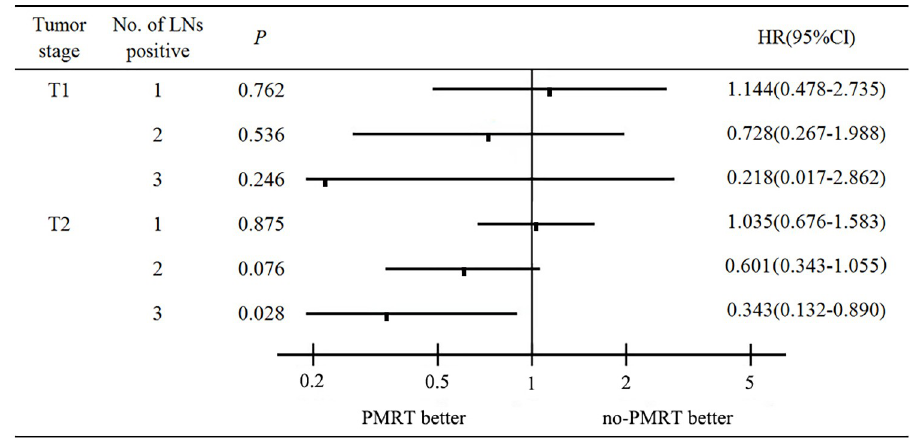
Fig 3. The forest plot of HR for BCSS in PMRT vs. no-PMRT group in T1-2N1M0 TNBC patients stratified by tumor size and the number of positive lymph nodes.